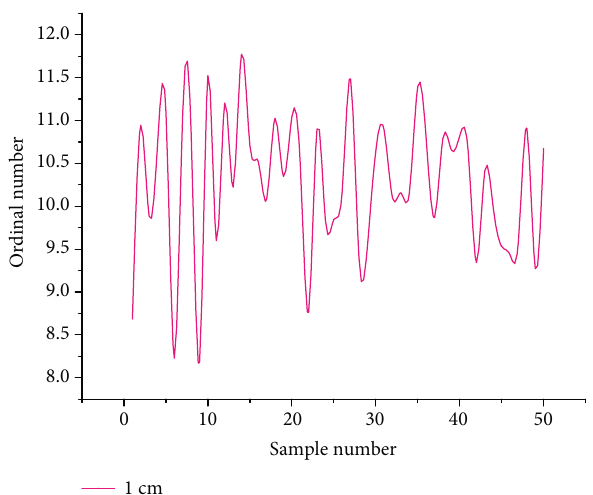
7: Identi fi cation coe ffi cient with defect thickness of 1cm.